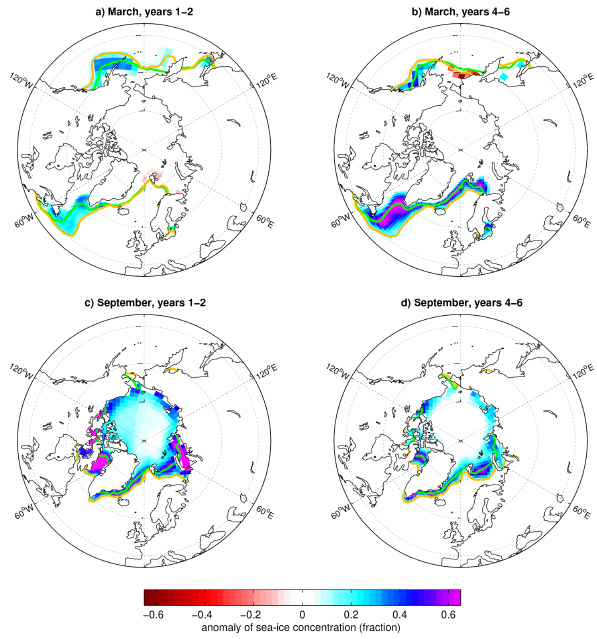
Figure 5. Ensemble-mean simulated March (top panels) and September (bottom panels) Arctic sea-ice concentration anomalies for integration years 1–2 (a, b) and 4–6 (c, d) of the SUPER1 en- semble. Only grid points where the anomaly is significant at 95% confidence ( n = 5; see methods) are shown. The green and or- ange lines indicate, respectively, the pre-eruption average and post- eruption average sea-ice